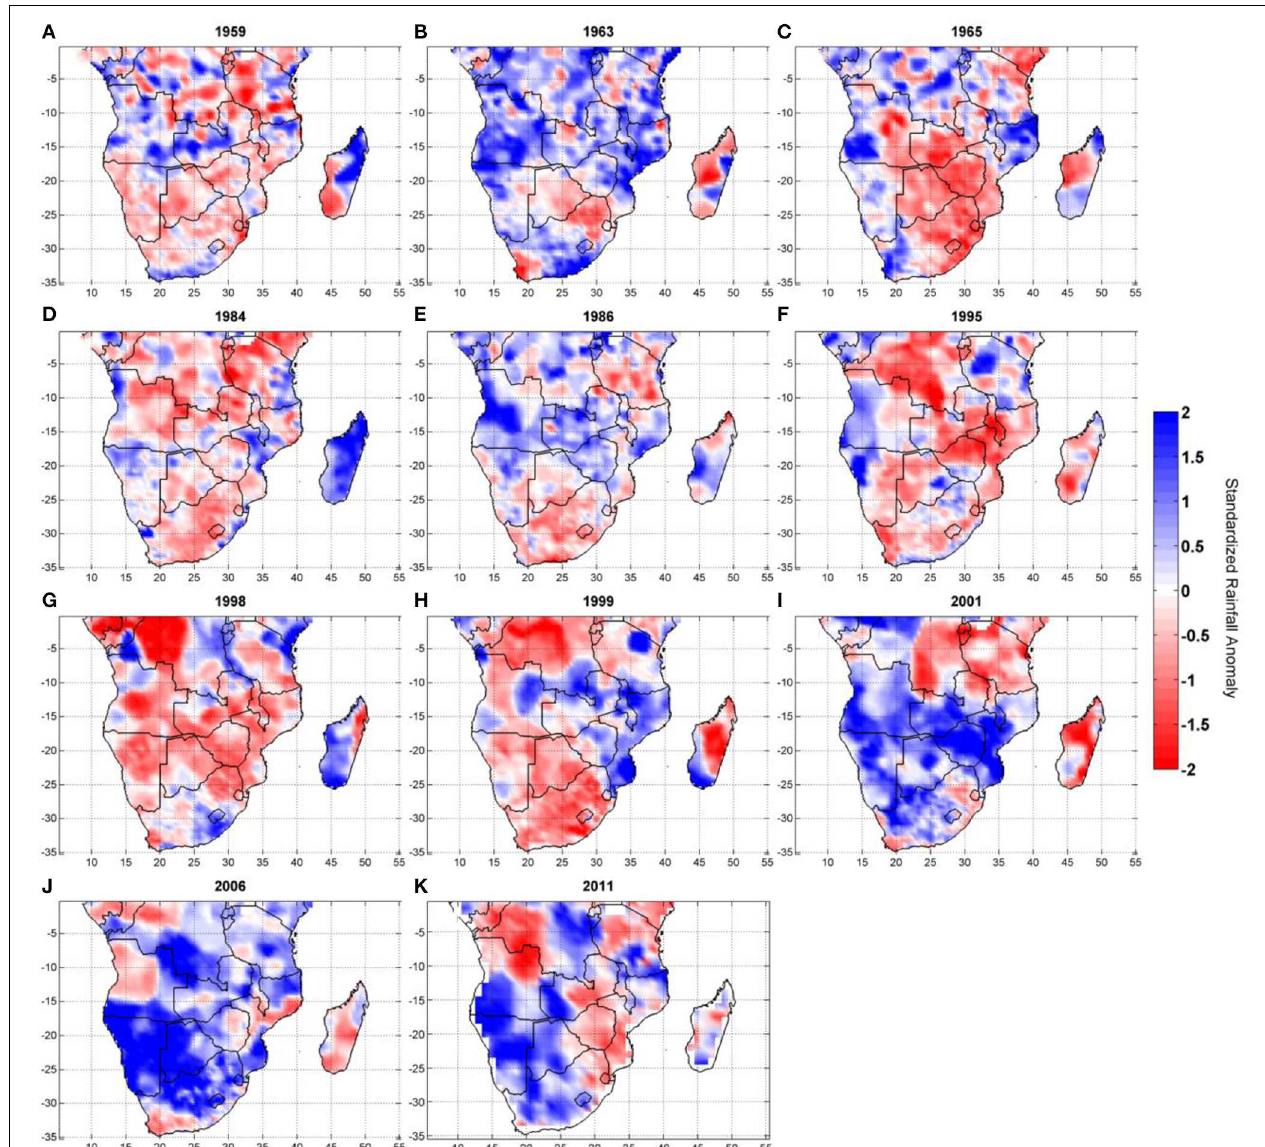
FIGURE 3 | FMA rainfall anomalies (contour interval 10mm) occurring during all warm SST events since 1950 using GPCC data (A) 1959, (B) 1963, (C) 1965, (D) 1984, (E) 1986, (F) 1995, (G) 1998, (H) 1999, (I) 2001, (J) 2006, and (K) 2011.